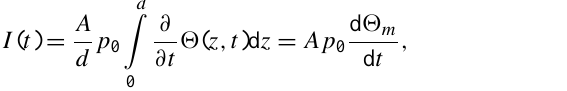
Table 1. Material properties of the PZT plate (PI Ceramic GmbH, 2015). Density, Thermal